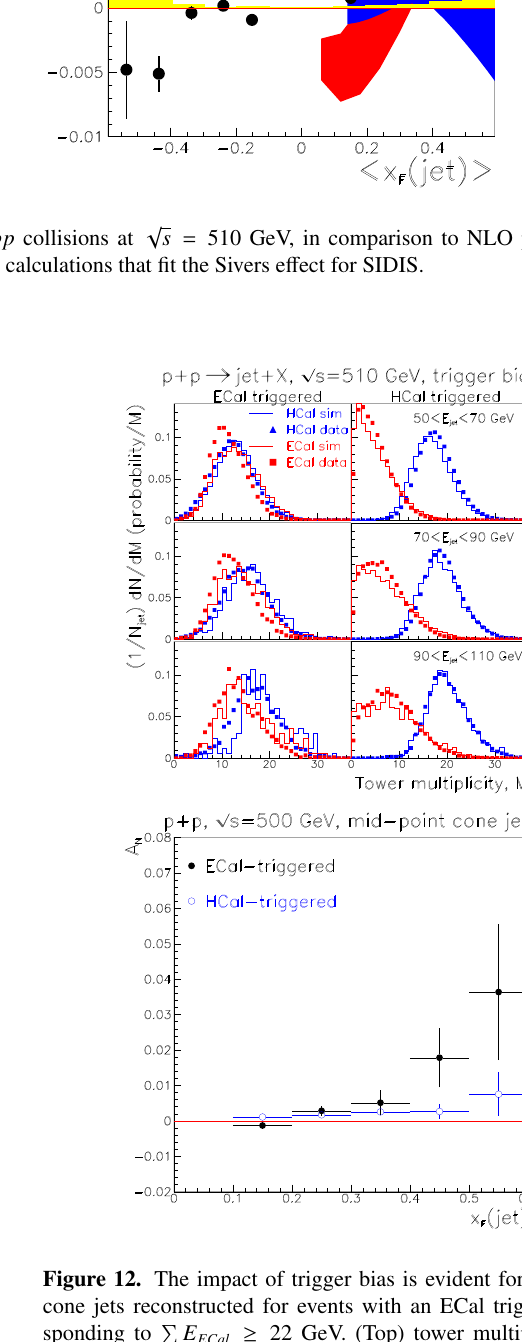
Figure 12. The impact of trigger bias is evident for mid-point cone jets reconstructed for events with an ECal trigger, corre- (cid:3) sponding to E ECal ≥ 22 GeV. (Top) tower multiplicity dis- tributions show a bias towards jets with larger electromagnetic multiplicities for an ECal trigger; and (Bottom) the trigger bias makes jets more π 0 like, thereby impacting their spin